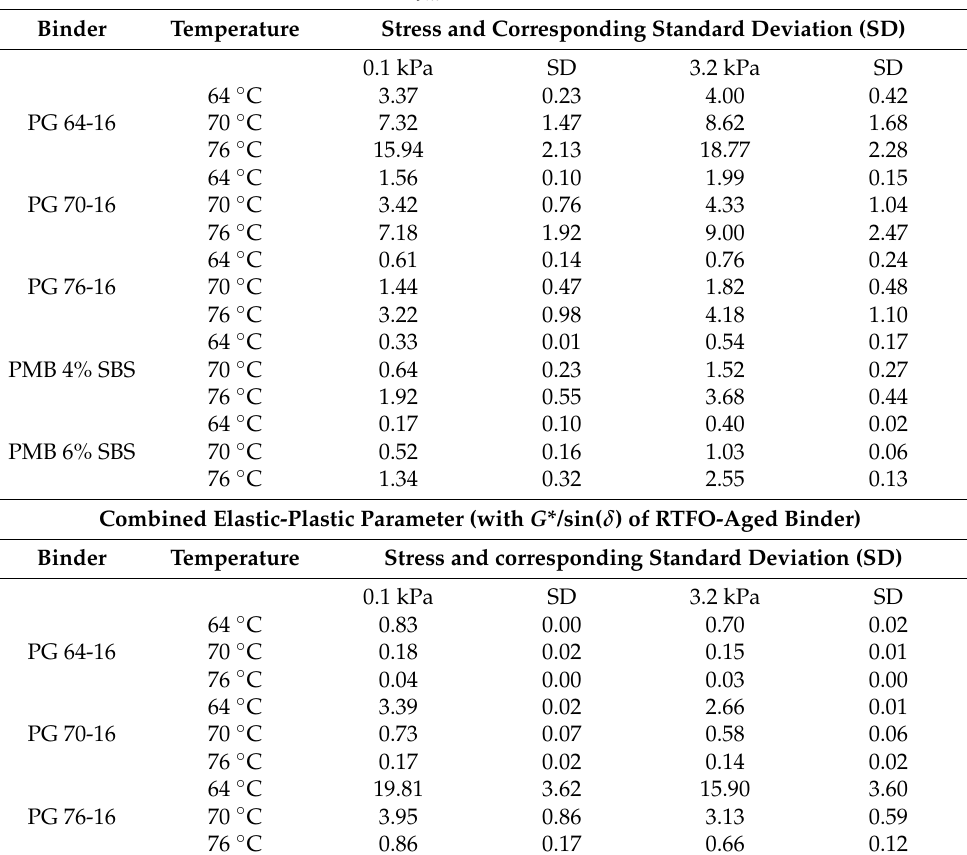
Table 4. J nr and CEP parameter results of the asphalt